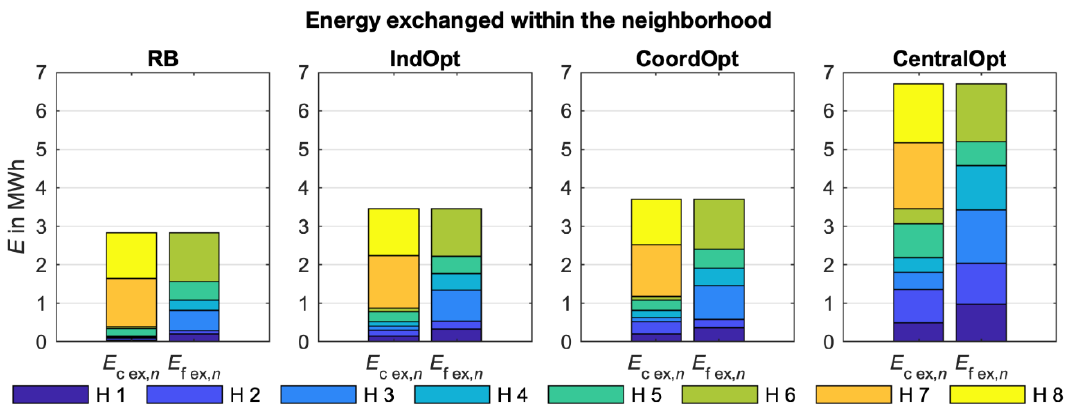
Figure 12. Energy consumed from the neighborhood ( E c ex, n ) and energy fed into the neighborhood ( E f ex, n ) by each individual household (H: household).